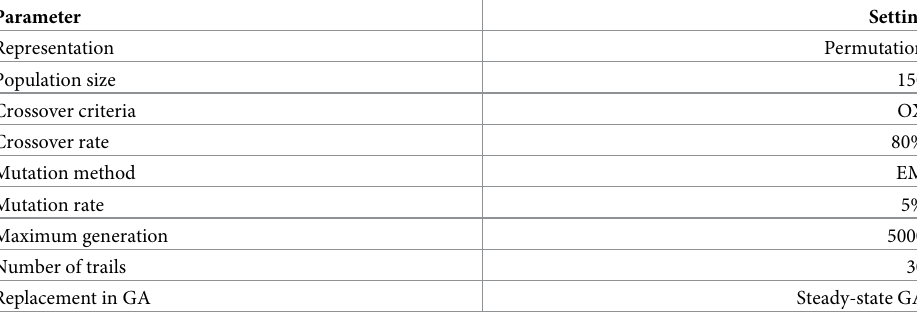
Table 5. Parametric configuration for